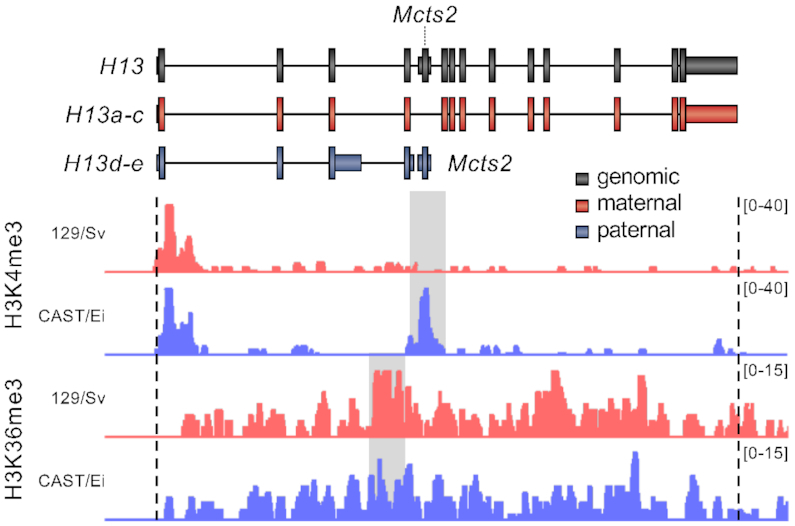
ChIP-seq profiles for H3K4me3 and H3K36me3 from hybrid immortalised mouse fibroblasts mapped to the maternal (129/Sv) or paternal (CAST/Ei) allele of Mcts2/H13. Genomic (black) and packed maternal (red) and paternal (blue) tracks are shown at the top. Coverage values have been normalised by input and are indicated on the y-axis. Allele-specific chromatin mark enrichments are highlighted in gray.